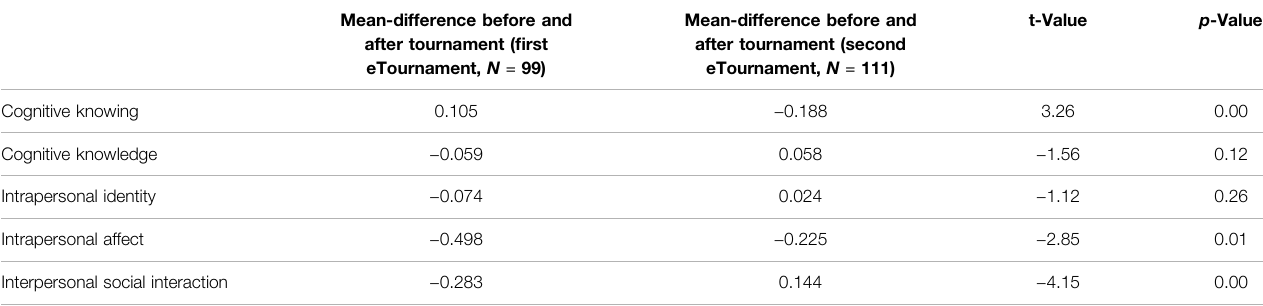
TABLE 6 | Independent-sampled t -test of Students ’ Global perspectives between fi rst and second eTournament. Mean-difference before and after tournament ( fi